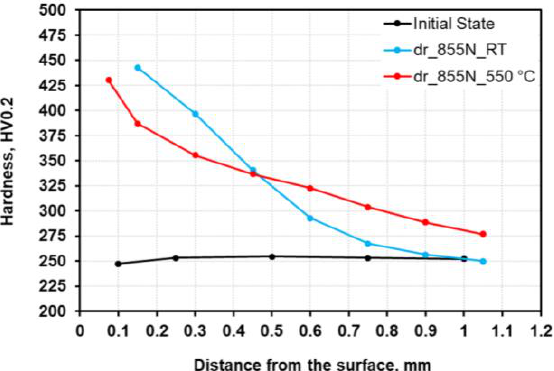
Figure 2. Hardness distribution in the near-surface area after deep rolling at 550 °C using a deep rolling force of 855 N. Data of the initial state condition and of the condition deep rolled at RT using a deep rolling force of 855 N were recompiled from [39].